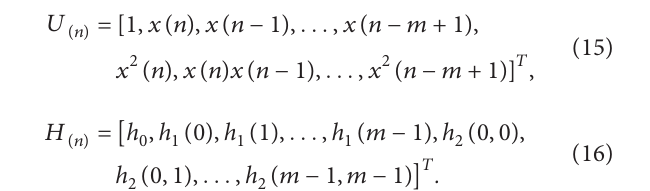
where “ n ” should not be less than the number of symbol types. Take Figure 2 as an example; the number of symbol types is 4, and the first three bit symbol series is 3, 0, and 2, and the corresponding code is 50 according to equation (10). After calcu- lating the code series, the probability of calculating each code symbol is P ( c ) � [ p ( c p ( c )] . 4 m